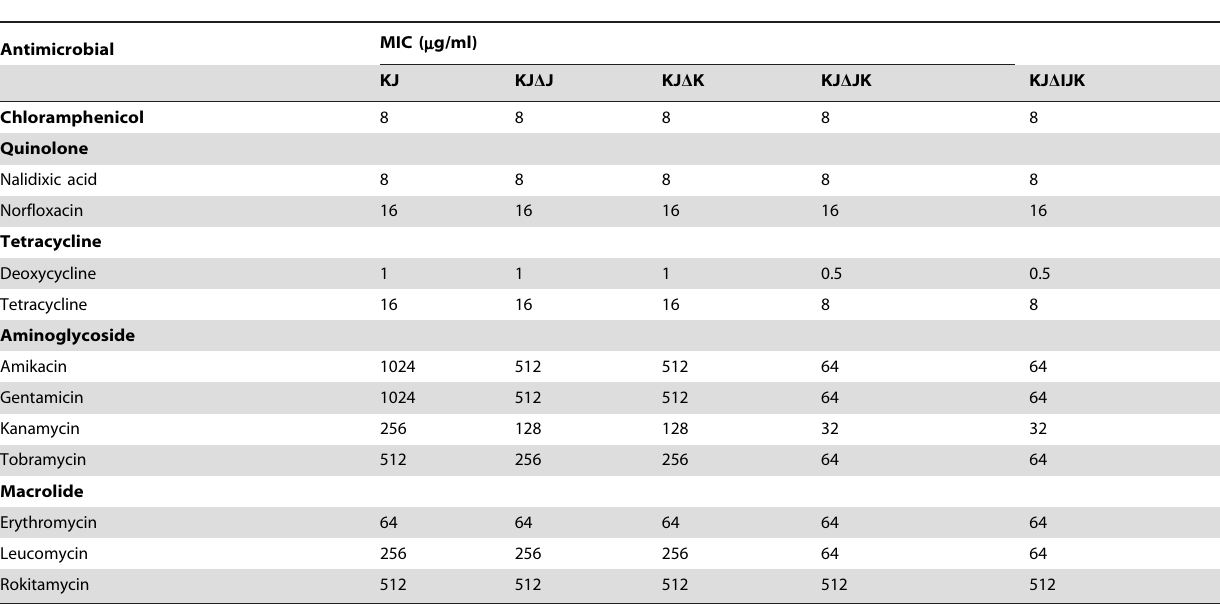
Table 1. Antimicrobial susceptibilities of S. maltophilia KJ and its derived deletion mutants.